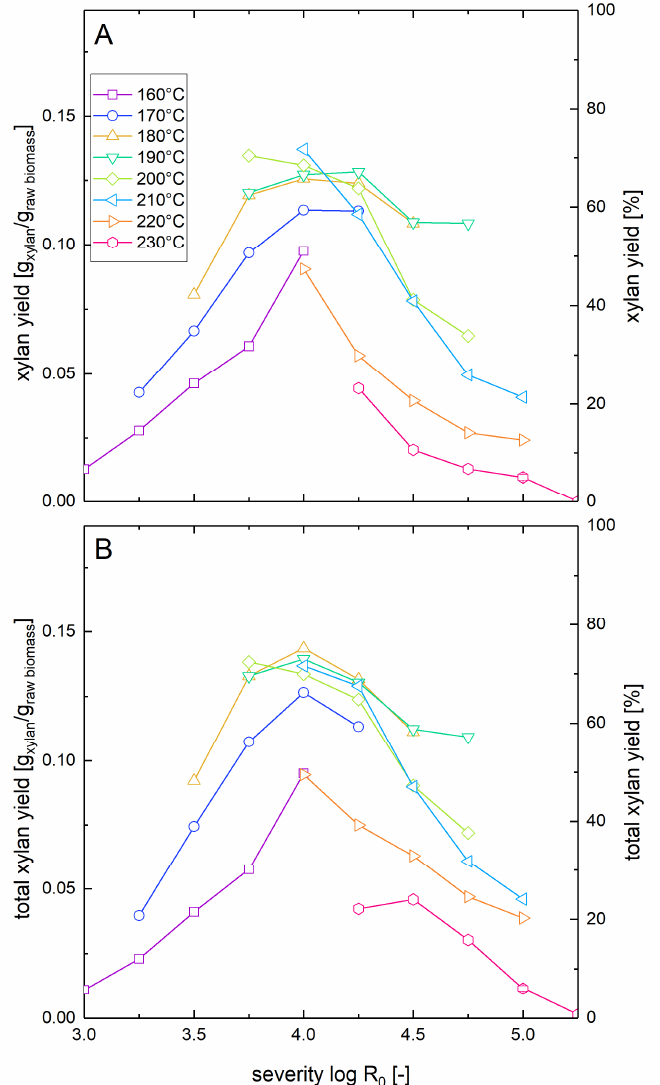
Figure 2. Solubilization of xylan after pretreatment and low solid enzymatic hydrolysis. The solubilization and recovery of xylan as xylose or soluble xylooligomers after pretreatment and enzymatic hydrolysis was determined ( A ) after whole slurry enzymatic hydrolysis or ( B ) after combined enzymatic hydrolysis of washed solids and separate acid hydrolysis of the prehydrolyzate as a function of the pretreatment severity. A glucan loading of 1% based on the unpretreated biomass was applied in enzymatic hydrolysis experiments.